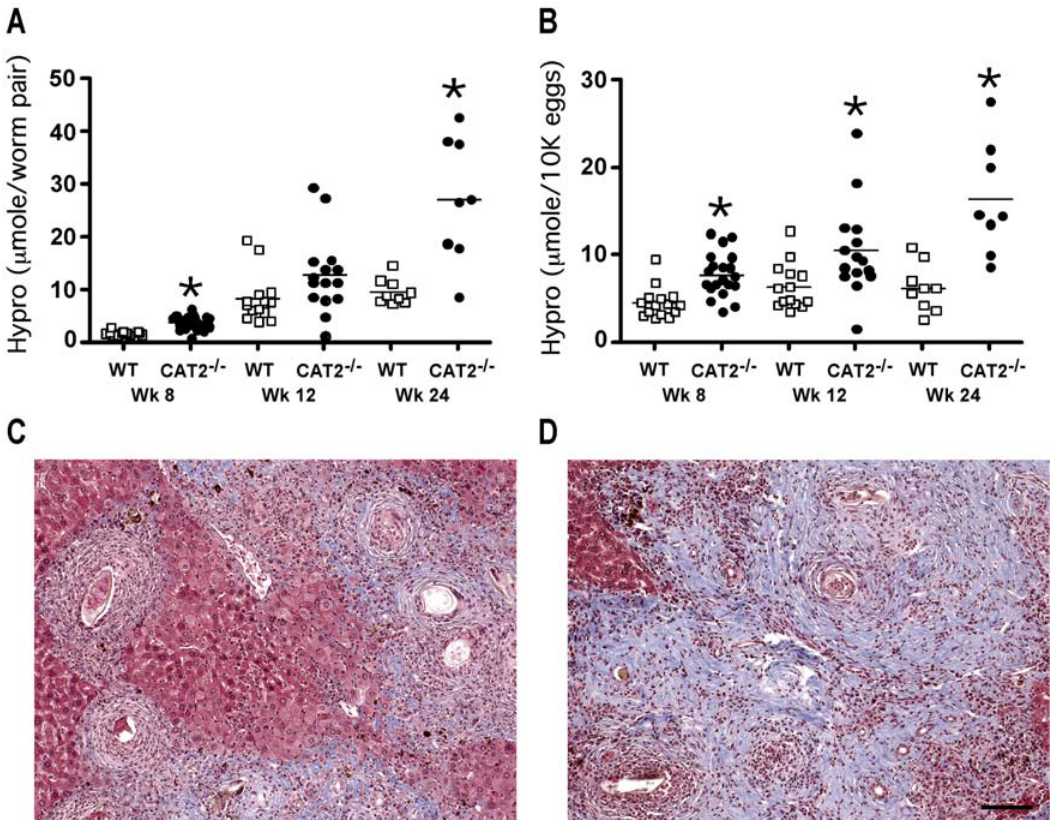
Figure 3. S.mansoni infected CAT2 2 / 2 mice develop exacerbated liver fibrosis. WT C57BL/6 (open squares) and CAT2 2 / 2 (filled circles) mice were infected with 30–35 S. mansoni cercariae and sacrificed on wk 8, 12 and 24 post-infection. A. Liver Fibrosis adjusted per worm pair ( m mol of hydroxyproline/worm pair). The * symbol denotes significant differences between WT and KO mice at that time point, p , 0.05. B. Liver Fibrosis per 10,000 eggs ( m mol of hydroxyproline/1 6 10 4 eggs). C. Representative liver granulomas stained with Masson’s Trichrome (8 wk infected C57BL/6 mouse). D. Representative liver granulomas stained with Masson’s Trichrome (8 wk infected CAT2 2 / 2 mouse). The bar in panel 3D=200 microns.